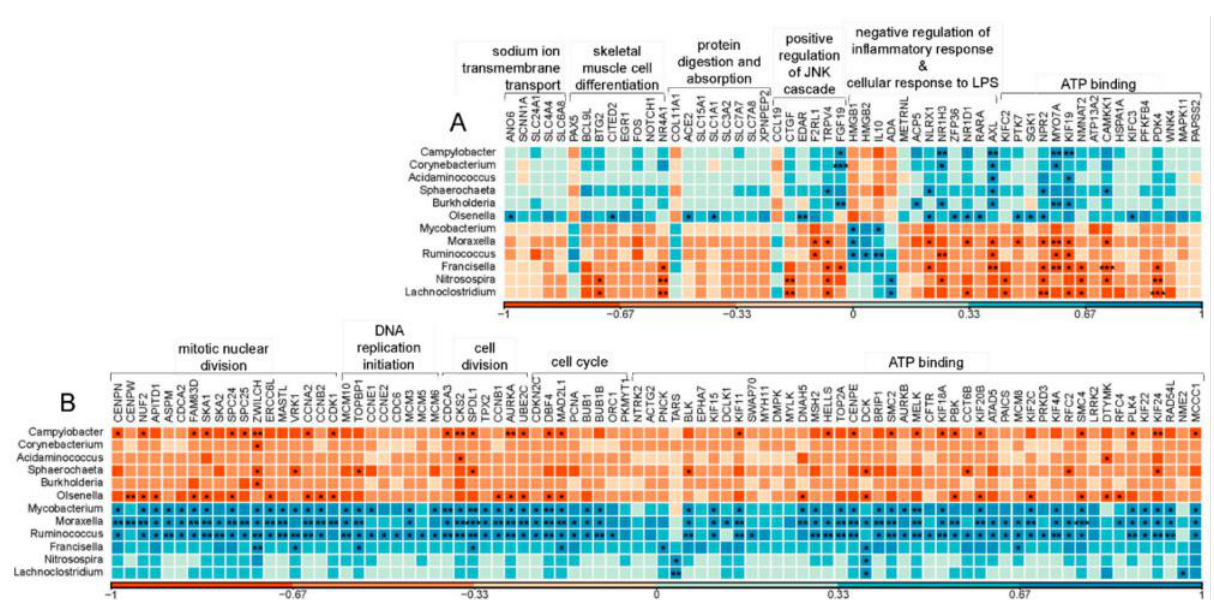
Figure 4. The Pearson correlation matrix between the active bacteria with significant abundance changes and the host jejunum DEGs. The color scale bar below ( A ) and ( B ) show the Pearson r value: the more positive the correlation (closer to 1), the darker the shade of blue; the more negative the correlation (closer to − 1), the darker the shade of red. ( A ) The IEGs enriched in ATP binding and the DEGs enriched in protein digestion and absorption, sodium ion transmembrane transport, skeletal muscle cell differentiation, negative regulation of inflammatory response, cellular response to LPS, and positive regulation of JNK cascade. ( B ) The REGs enriched in ATP binding and the DEGs enriched in cell cycle, cell division, mitotic nuclear division, and DNA replication initiation; * p < 0.05; ** p < 0.01; *** p <